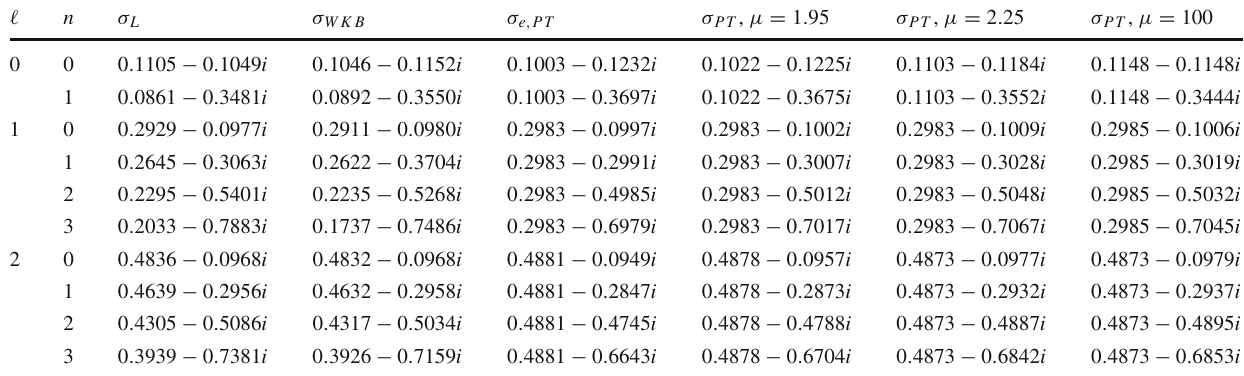
Table 4 Normal modes for scalar perturbations of the noncommutative geometry inspired Schwarzschild metric. The third and fourth columns represent the numerical values found by [50] and [43], respectively, for a classic Schwarzschild black hole. Here, σ PT is the dimensionless fre-